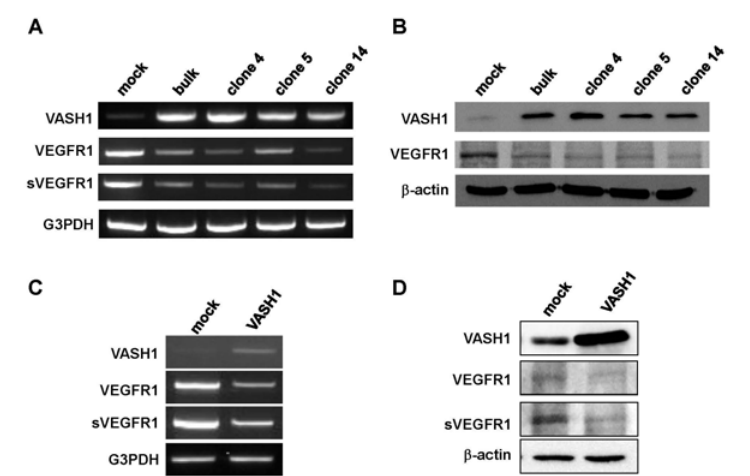
Figure 3. VASH1 inhibits VEGFR-1 and sVEGFR-1 expression in ECs.